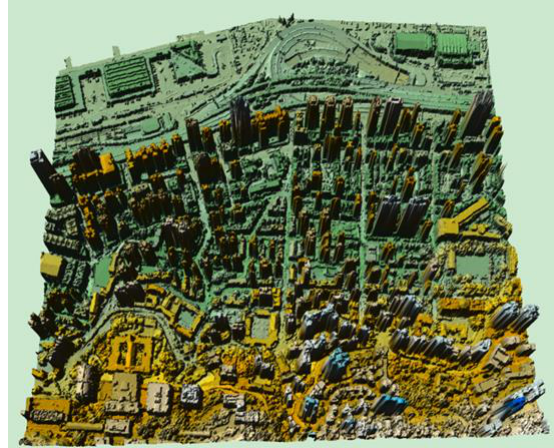
Fig.12 The DSM from LiDAR data in Hong